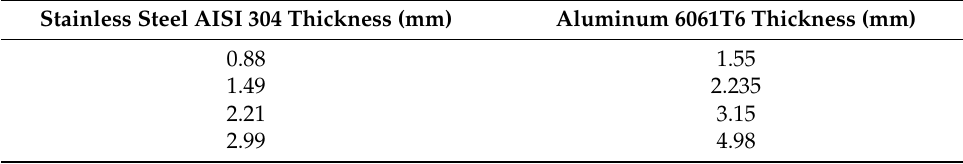
Figure 8. Plates of different materials used in the experiments. Table 3. Plates used for the experiments.